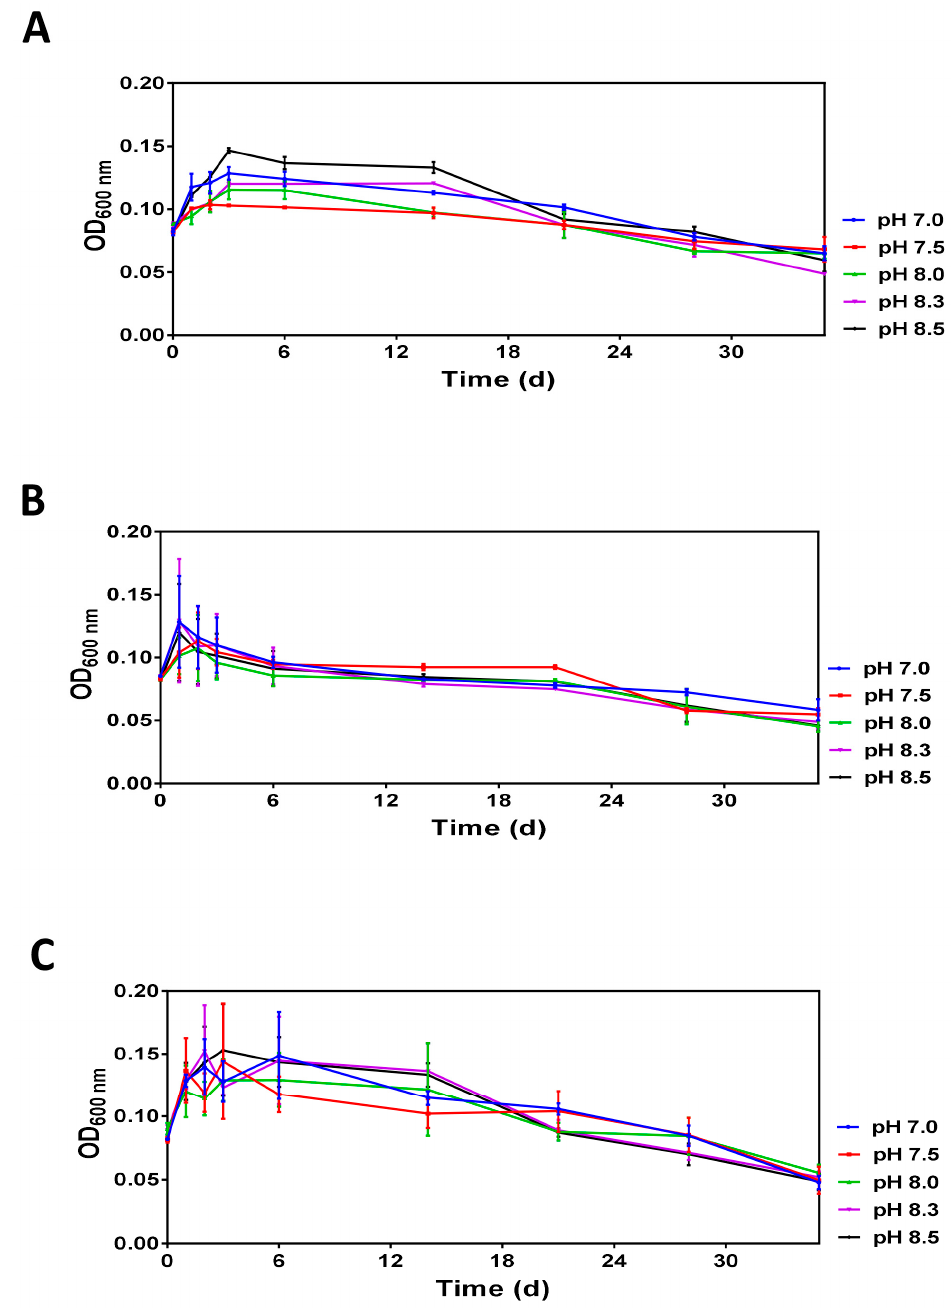
Figure 2. The time-dependent changes in the optical density (OD 600 nm ) of V. harveyi populations incubated at 20 °C ( panel A ), 25 °C ( panel B ) and 30 °C ( panel C ) Experiments were performed with samples obtained after dilution of overnight cultures with ASW supplemented with 0.1 M HEPES at pH 7.0, 7.5, 8.0, 8.3 and 8.5. The mean values and standard deviation (indicated by vertical bars) were calculated based on the data obtained in 3 independent experiments. The pH was measured at each time point, and it remained unchanged.